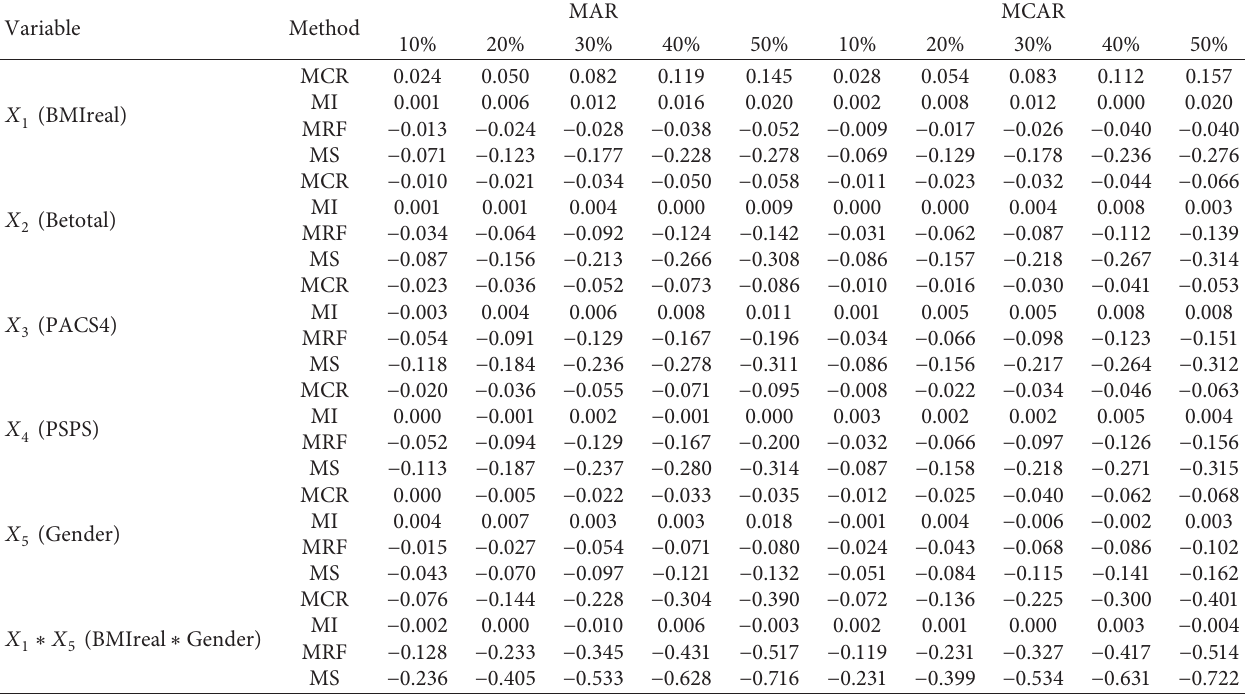
Table 1: Comparison of the performance of imputation methods based on the average raw bias (RB) of regression coefficients over 1000